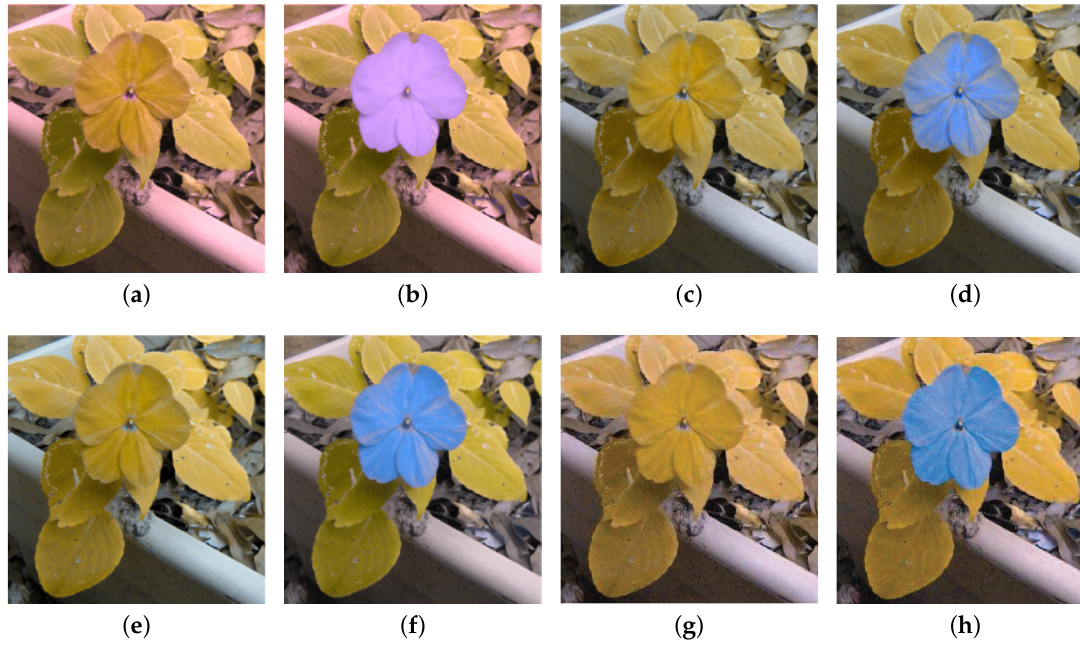
Figure 12. The comparison of deuteranopia simulation of the flower image in Figure 9a. ( a ) Machado’s CVD simulation. ( b ) Our re-coloring technique after Machado’s CVD simulation. ( c ) Brettel’s CVD simulation. ( d ) Kuhn’s re-coloring technique after Brettel’s CVD simulation. ( e ) Rasche’s CVD simulation. ( f ) Rasche’s re-coloring after CVD simulation. ( g ) Huang’s CVD simulation. ( h ) Huang’s re-coloring after CVD